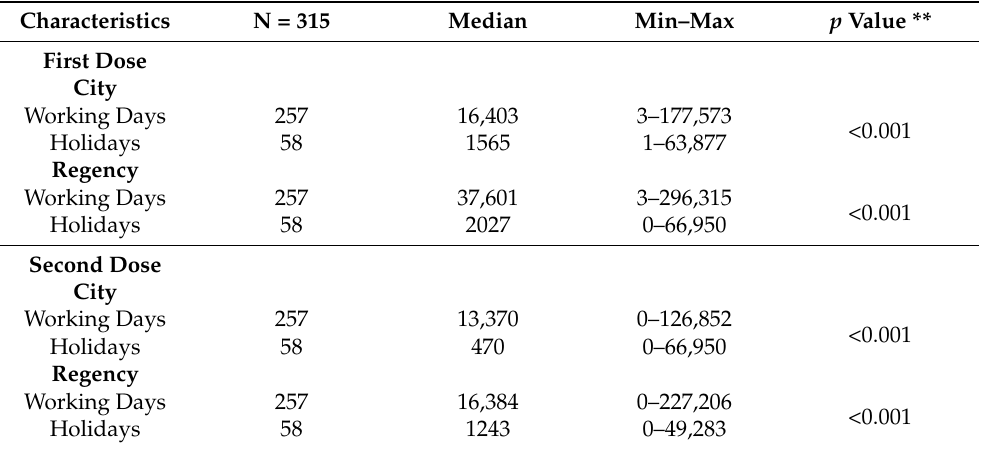
Table 5. Statistical analysis of total daily vaccination based on day type in both city and regency settings.